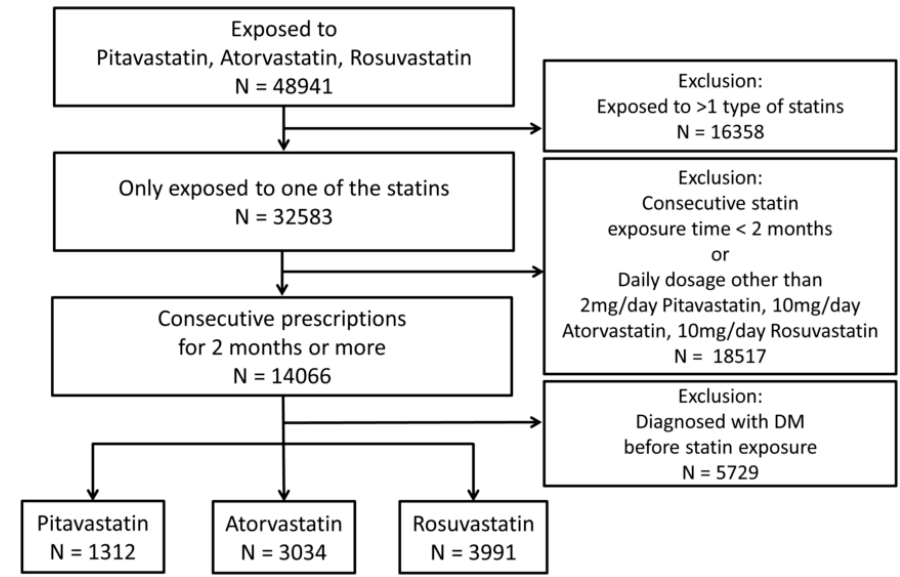
Figure 1. Flowchart of study population enrollment based on the inclusion and exclusion criteria. DM: diabetes mellitus; N: number of patients.